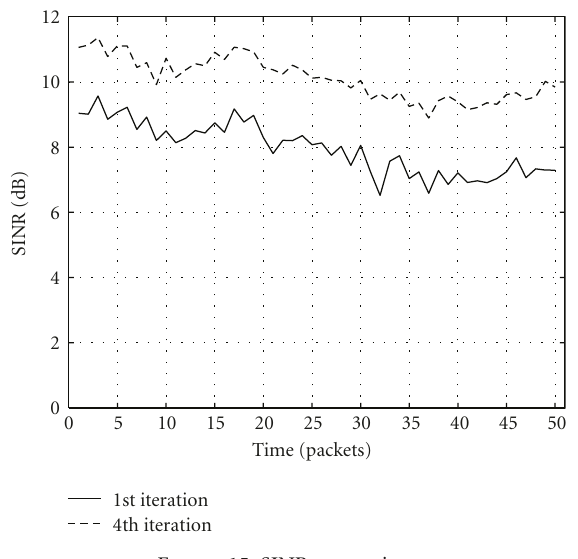
Figure 15: SINR versus